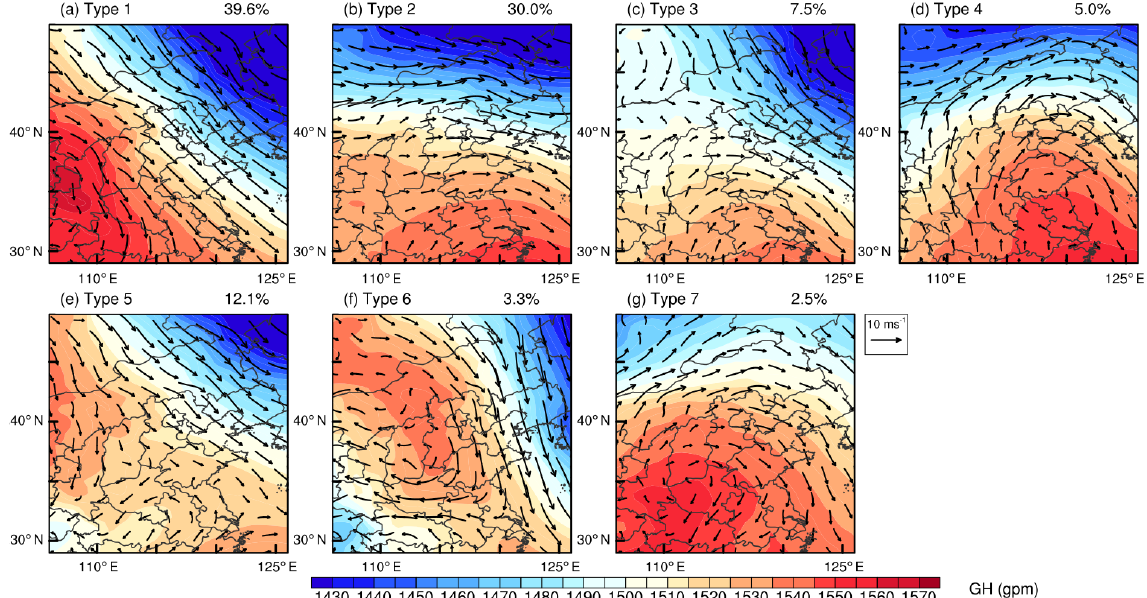
Figure 3. The 850hPa geopotential height (GH) fields and wind vector fields for the seven classified patterns. The occurrence frequency of each synoptic pattern is also